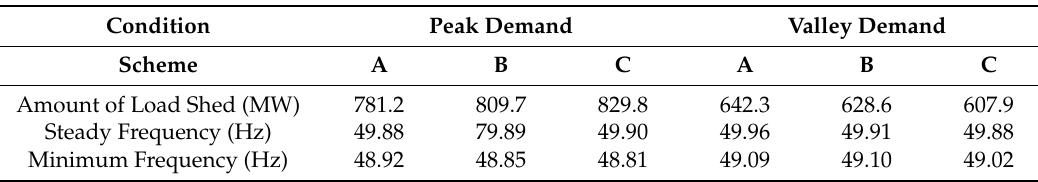
Table 6. Performance of the different UFLS